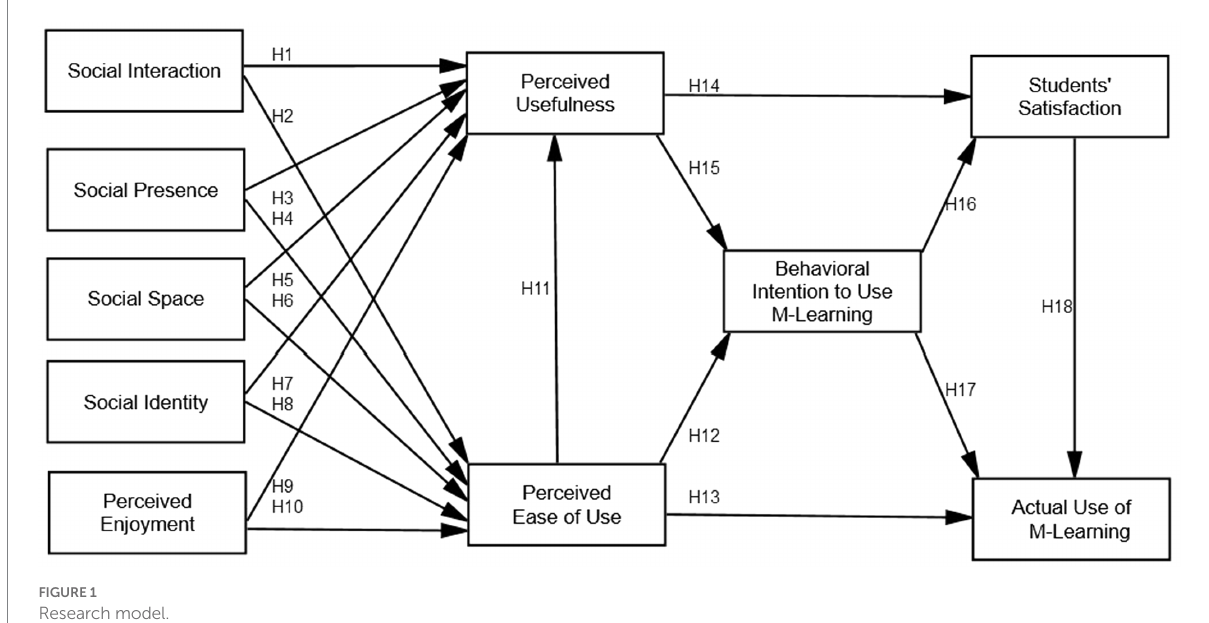
FIGURE 1 Research